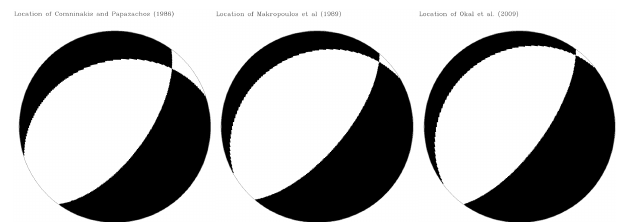
Figure 14. Best fitting fault plane solutions for a source depth of 25km for the three locations by (left) Comninakis and Papazachos (1986), (middle) Makropoulos et al. (1989) and (right) Okal et al.